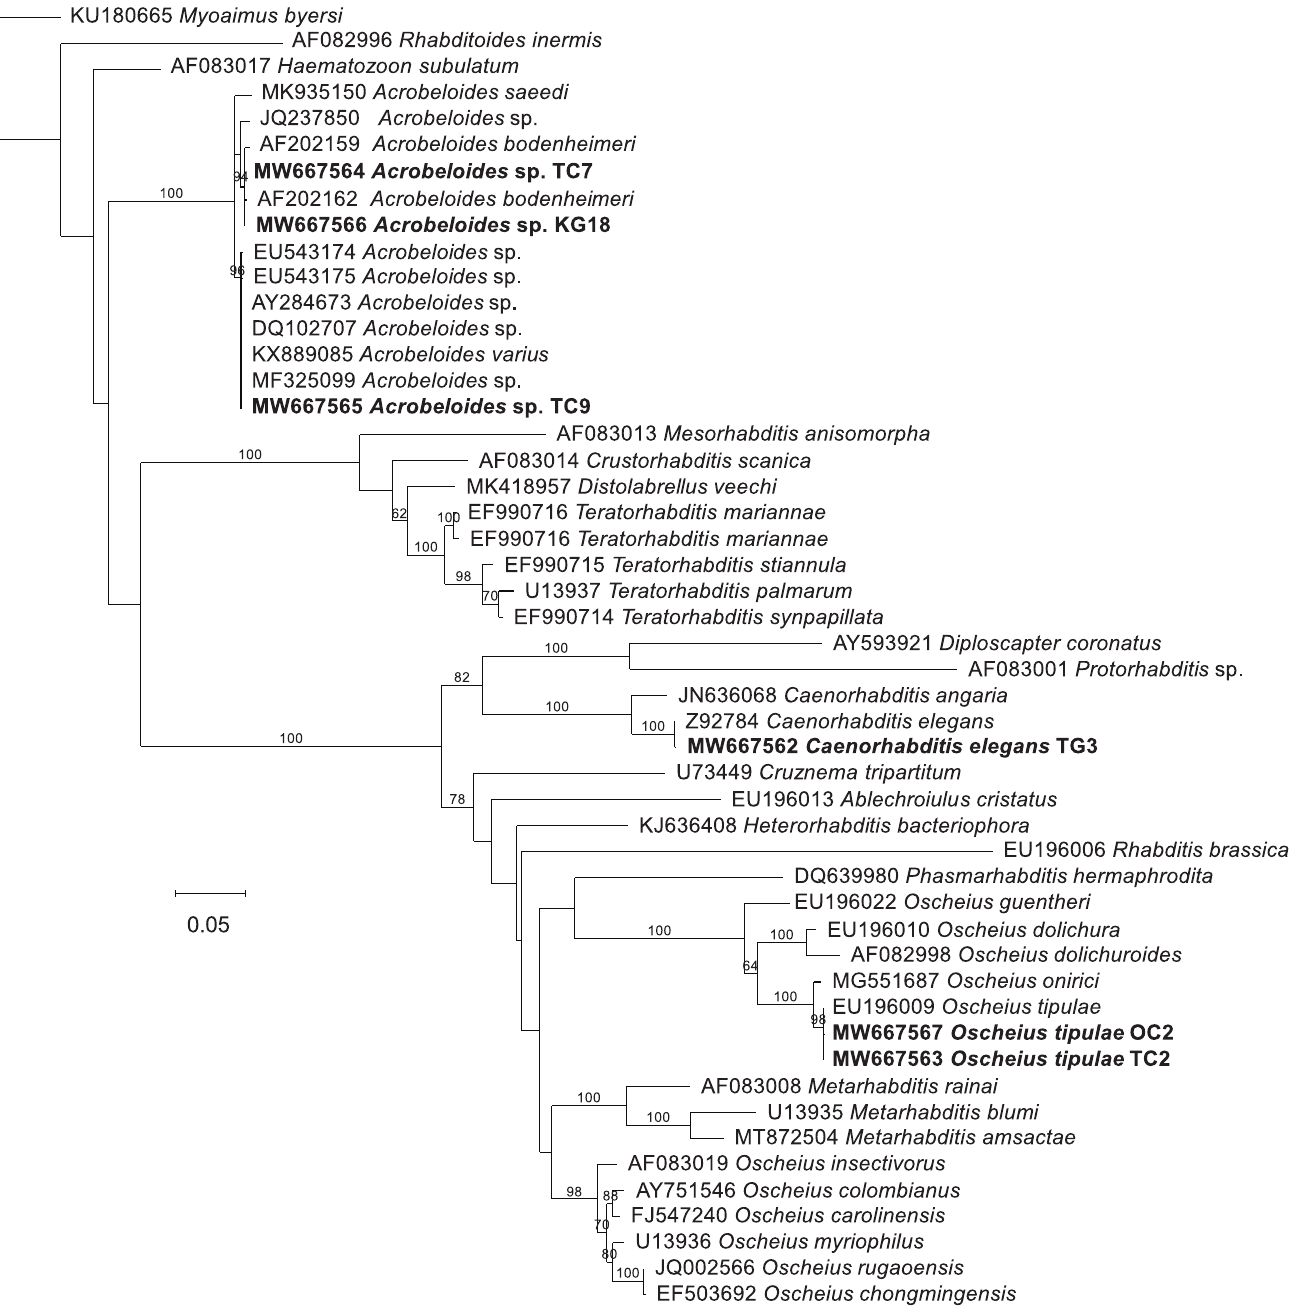
Fig 1. Phylogenetic tree based on ribosomal DNA sequences of the nematodes isolated in this study and several related species. Phylogenetic relationships based on 18S rRNA gene sequences were inferred by using the Maximum Likelihood method based on the General Time Reversible model. The tree with the highest log likelihood (-9560.62) is shown. The percentage of trees in which the associated taxa clustered together is shown next to the branches. A discrete Gamma distribution was used to model evolutionary rate differences among sites (5 categories (+ G , parameter = 0.8832)). The tree is drawn to scale, with branch lengths measured in the number of substitutions per site. NCBI accession numbers of the sequences used for the analyses are shown.